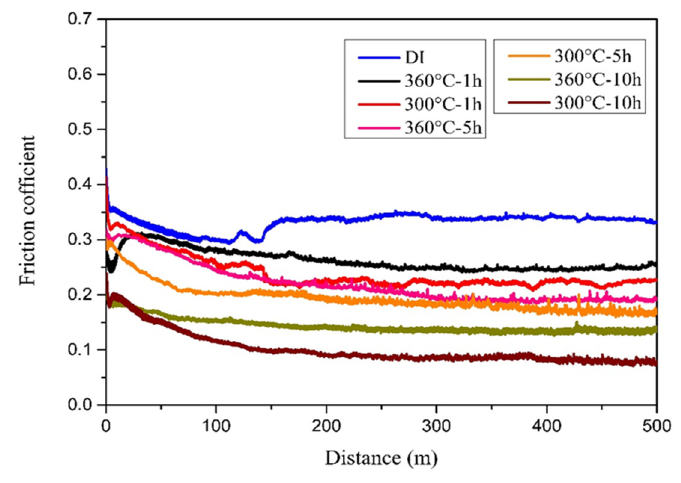
Figure 10. Comparison of friction coefficients among the specimens after wet wear testing.